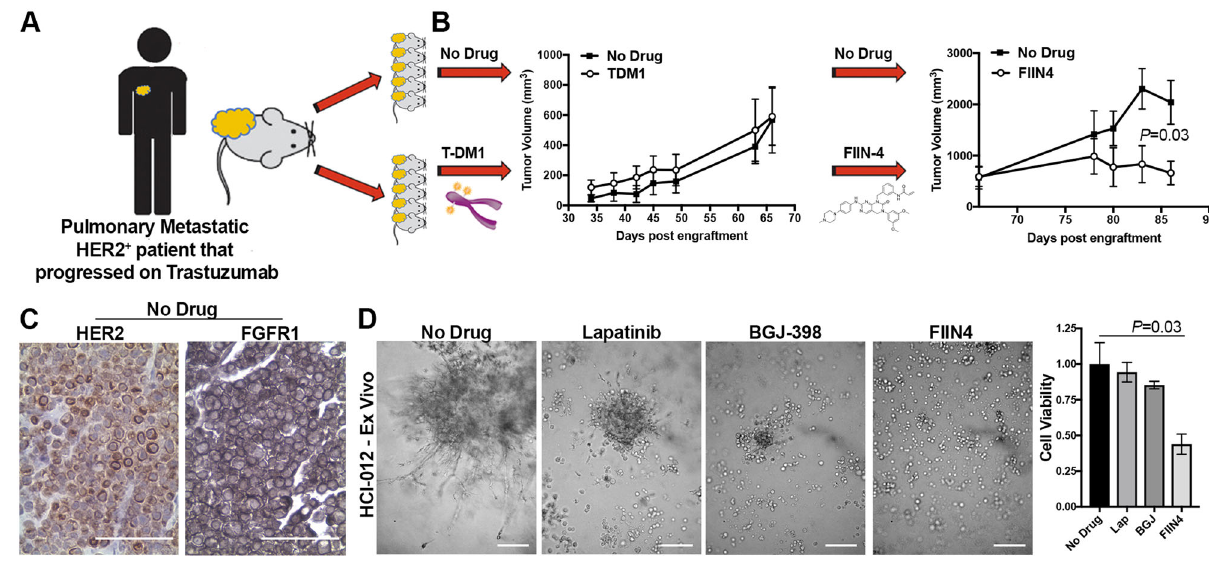
Fig. 7 Trastuzumab-resistant patient-derived xenografts are sensitive to covalent inhibition of FGFR. A Schematic representation of the expansion protocol of HCI-012. B Tumor-bearing mice were split into two cohorts consisting of an untreated group and a group that was initially treated with T-DM1 (5 mg/kg). Due to the lack of response to TDM1, these animals were switched to FIIN4 (25 mg/kg/p.o.d). Tumor size was measured by digital caliper measurements at the indicated time points. Data are the mean ± SE of 5 mice per group resulting in the indicated P value. C Representative histological sections of untreated HCI-012 tumors stained with antibodies for HER2 and FGFR1. D Ex vivo HCI-012 tumor cells were grown for 20 days under 3D culture conditions in the presence or absence of the indicated compounds. Representative images are shown and cell viability was quanti fi ed by cell titer glow. Data are mean ± SD of triplicate wells treated with the indicated